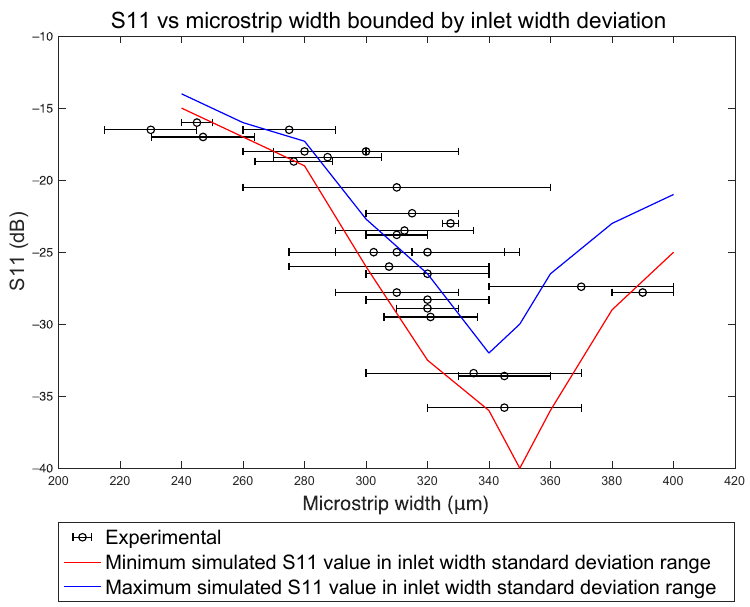
Figure 4. Simulated performance across the average +/ − standard deviation of inlet width at each microstrip width forming ranges of RF performance. The bounds illustrate the capacitive coupling effects (inlet width) on S11, but do not enable full predictive performance metrics.